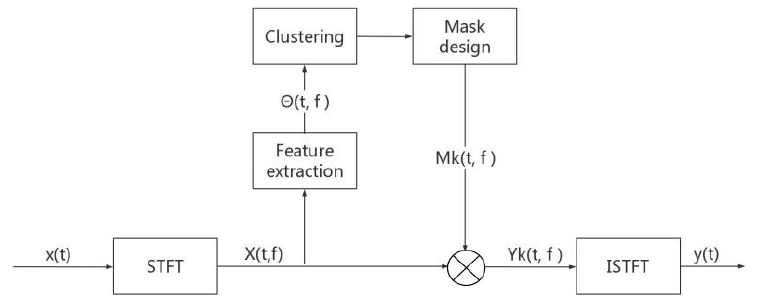
Figure 1. Example of T-F mask